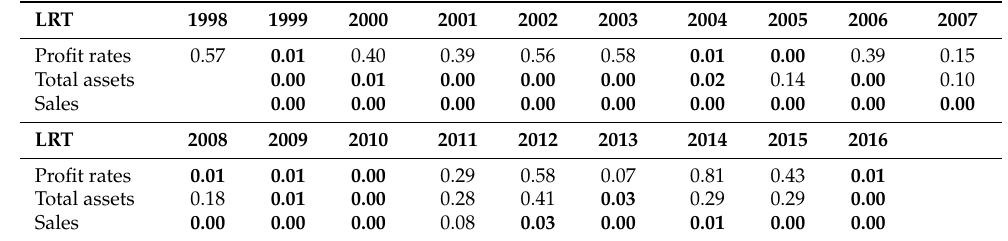
Table A3. P -values of the likelihood ratio test for profit rates and growth rates of total assets and sales. The null hypothesis is the asymmetric Laplace distribution, while the alternative hypothesis is the AEP distribution. Results refer to the 200 largest long-lived firms, according to their sales in 2016. In bold, we underlined P -values below 5%.